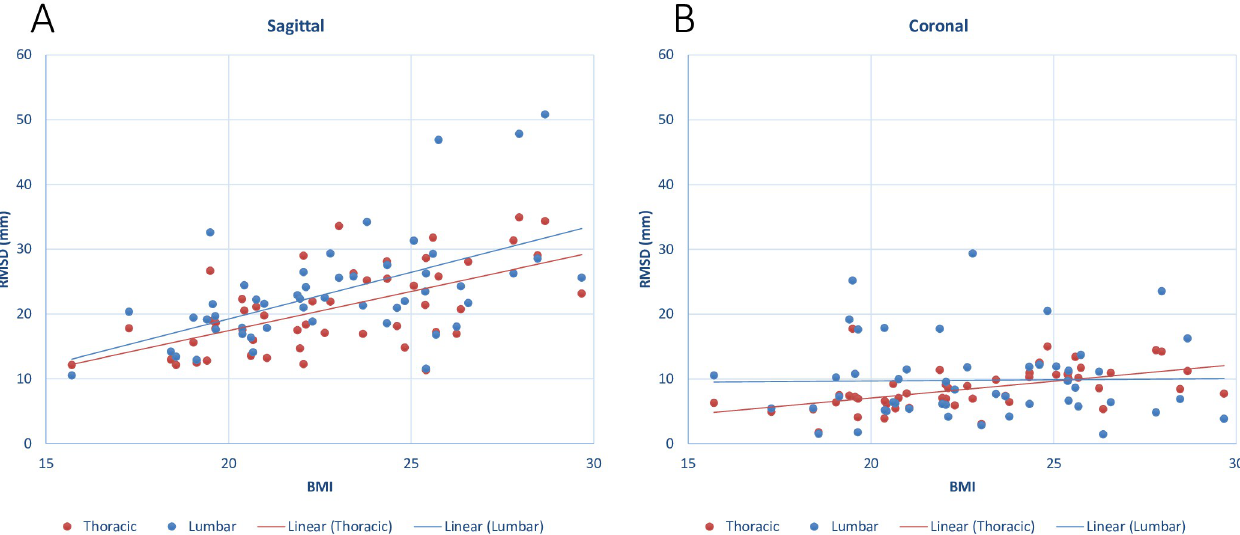
Fig 4. Comparison of the influence of BMI on the fiducial marker—Spinous process RMSD between the thoracic and lumbar regions. The y-axis shows the RMSD between the SCP and the FMP within the specified spinal region of each participant. The x-axis shows the BMI of the participant. The thoracic (red) and lumbar (blue) region RMSE’s are fitted with a linear trendline in both the coronal and sagittal views. In the sagittal view (A), RMSD tends to increase with BMI in both the thoracic and lumbar regions. In the coronal view (B), the thoracic RMSD tends to increase with BMI, where as the Lumbar RMSD maintains a horizontal trend.